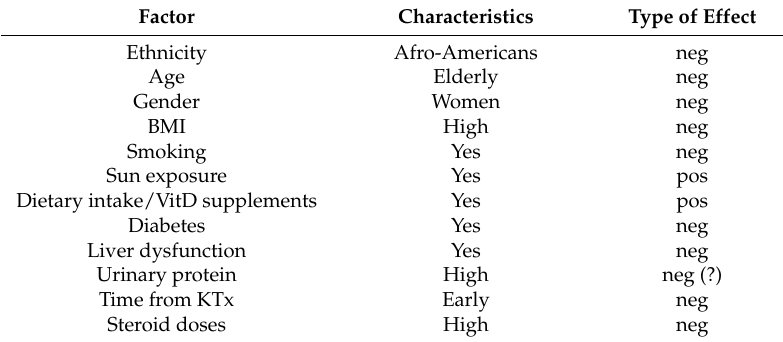
Table 2. Factors which can play a role in the different prevalence of the vitamin D deficiency/insufficiency status in KTx patients (neg = increases the risk for the finding of low total vitamin D levels; pos = reduces the risk for the finding of low vitamin D levels; BMI = body mass index; KTx = kidney transplantation)